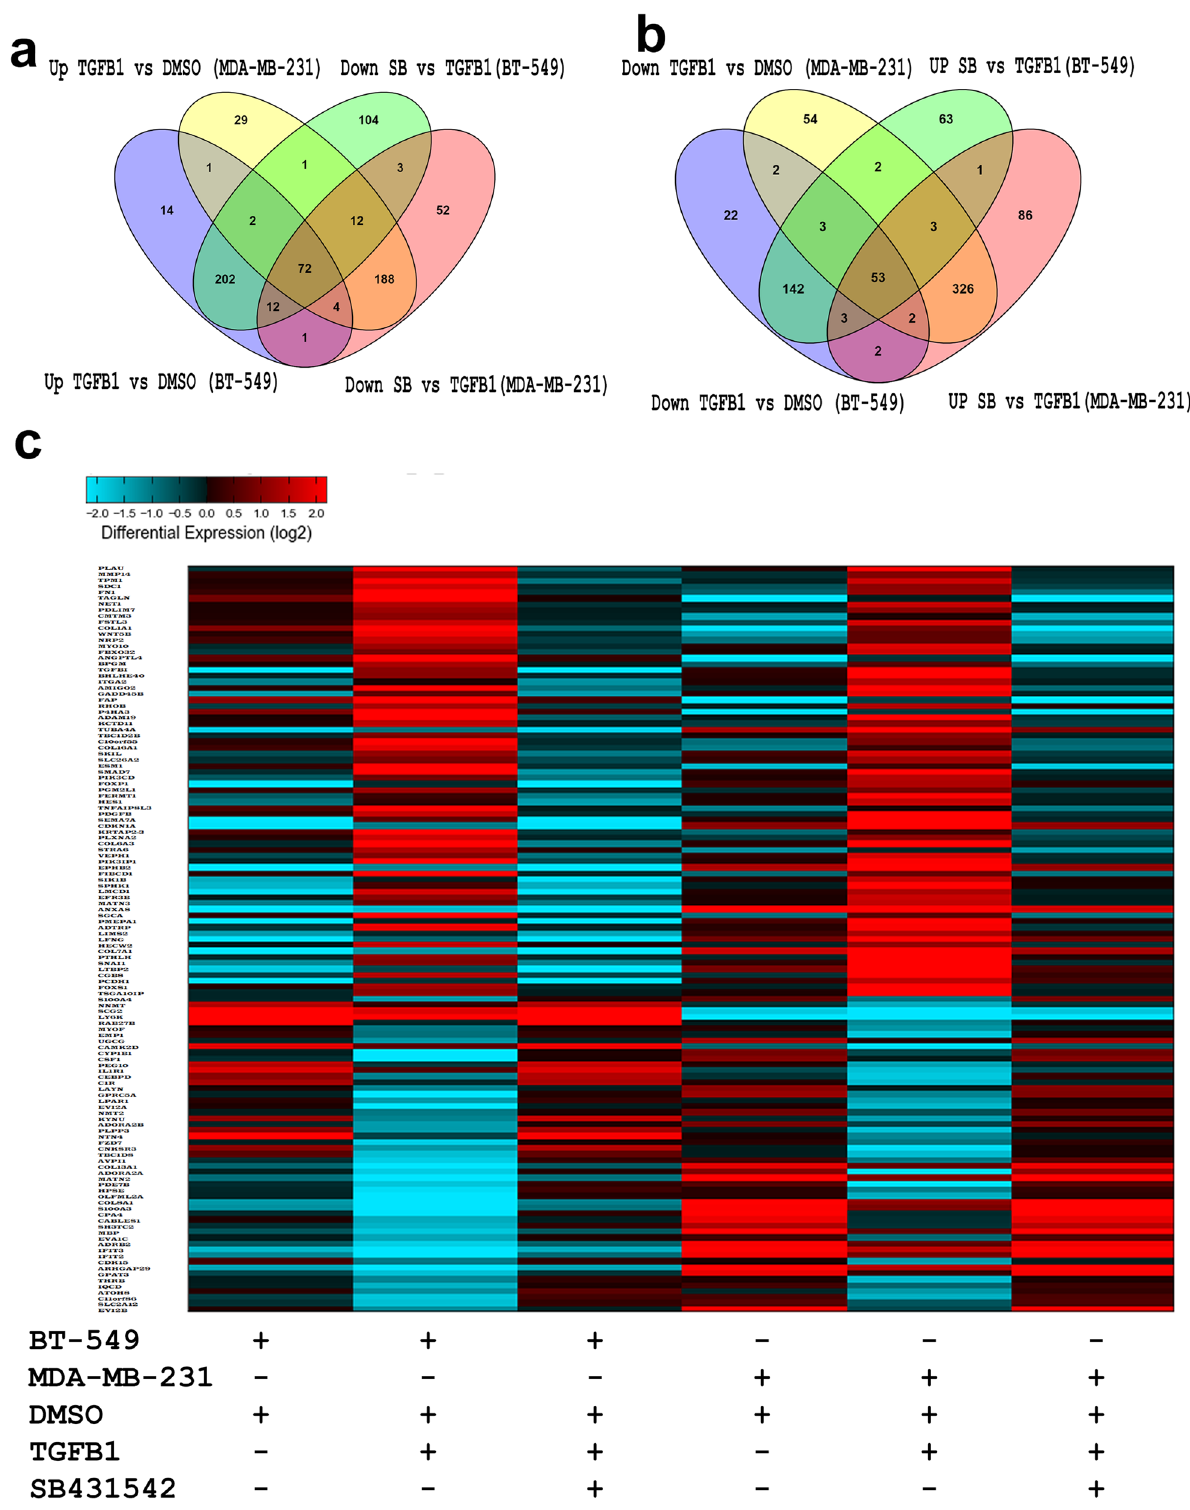
Figure 2. Venn diagraph depicting the overlap in upregulated ( a ) or downregulated ( b ) genes in BT-549 and MDA-MB-231 under the indicated experimental conditions. Upregulated genes are defined as the genes upregulated (FC ≥ 2.0) by TGFB and those were downregulated (FC ≤ 2.0) by SBSB431542. Downregulated genes were defined as the genes downregulated by TGFB1 (FC ≤ 2.0) and those were induced by SB431542 (FC ≥ 2.0). ( c ) Heatmap depicting commonly altered (up and down) protein coding genes under different experimental